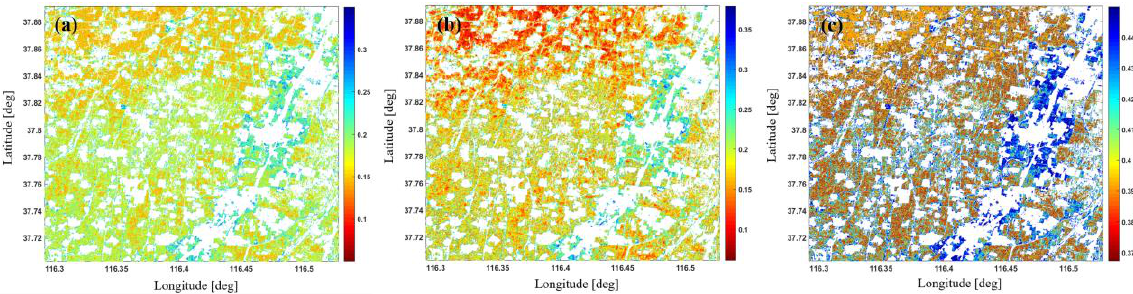
Figure 4. Spatial distribution map of SM inversion value. ( a ) 16 April 2019; ( b ) 28 April 2019; ( c ) 10 May 2019.